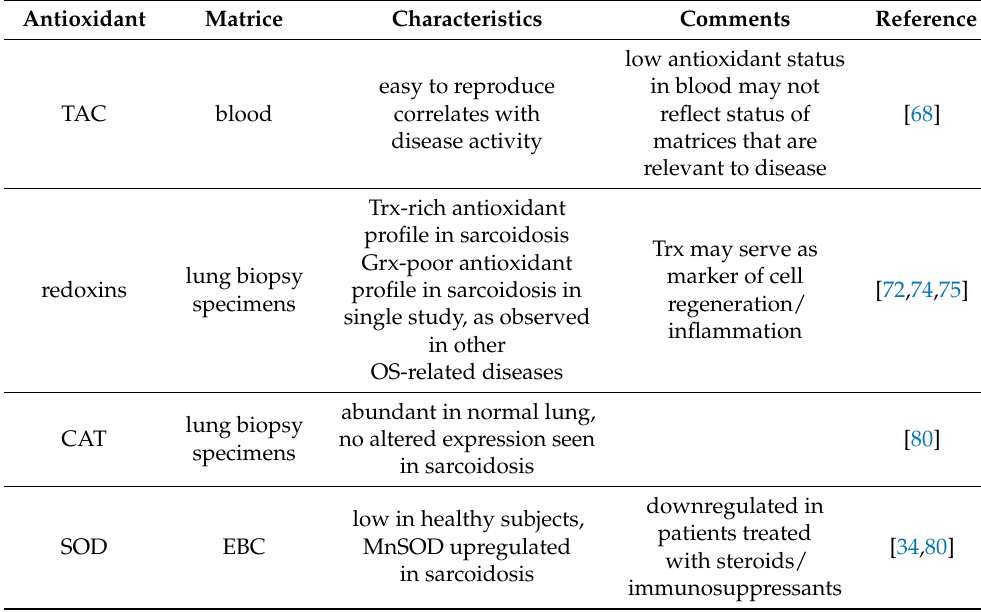
Table 2. Overview of the most relevant antioxidants in